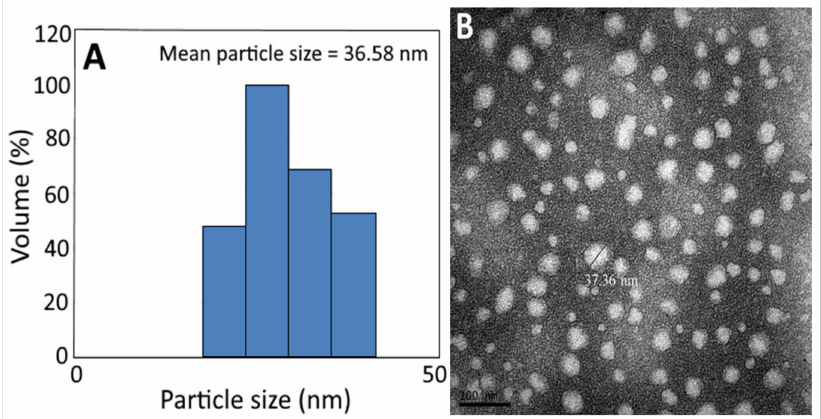
Figure 3. Particle size distribution of C. osmophloeum leaf nanoemulsion, as determined by the dynamic light scattering (DLS) method, with a mean particle size of 36.58 nm ( A ), along with its transmission electron microscopy image, with a mean particle size of 37.36 nm ( B